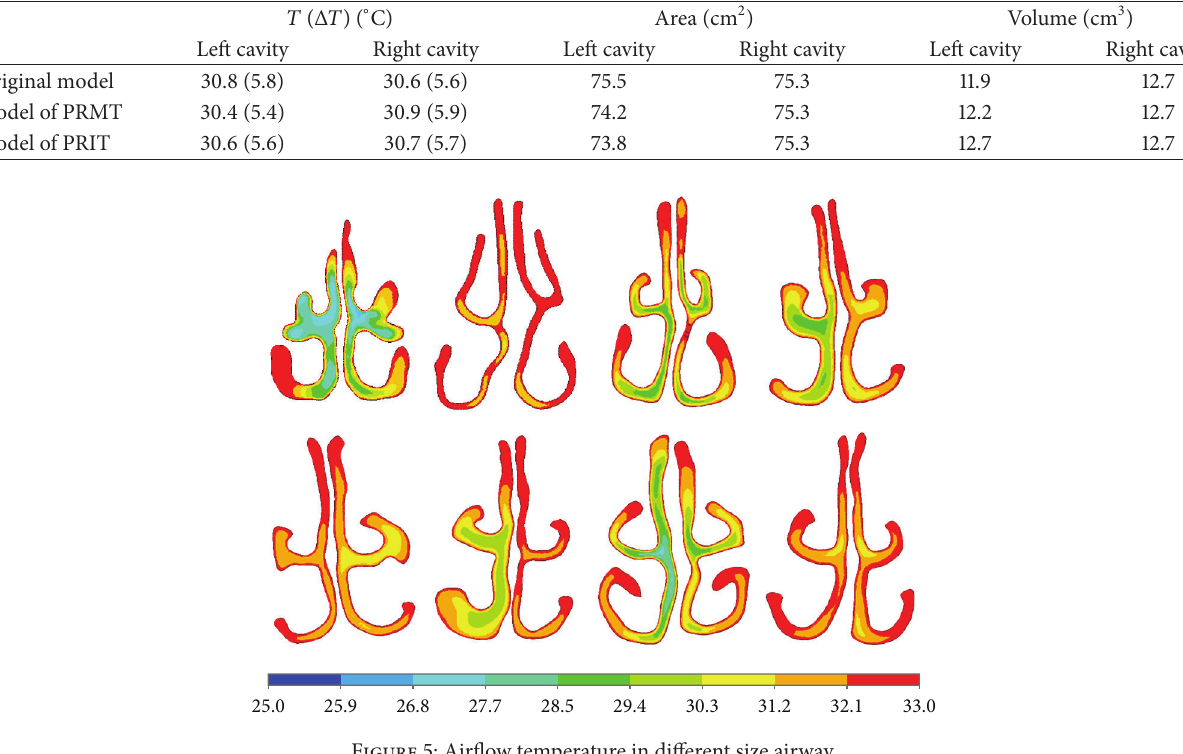
Table 1: Simulation results of heating airflow in the selected nasal model and its two variants.